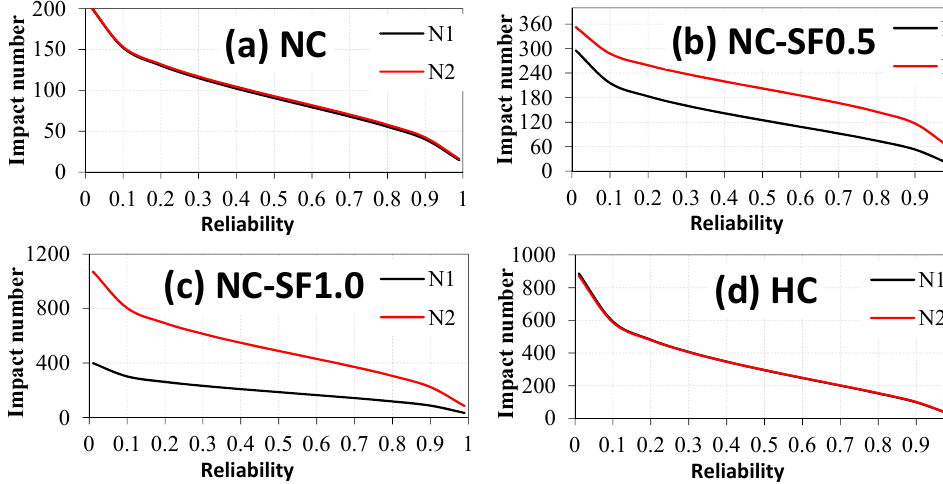
Figure 13. Impact strengths at the required levels of reliability.